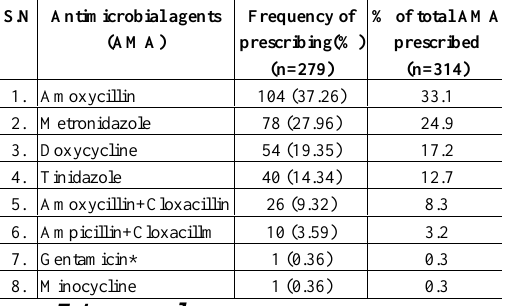
Table IV. Pattern of Prescribing of